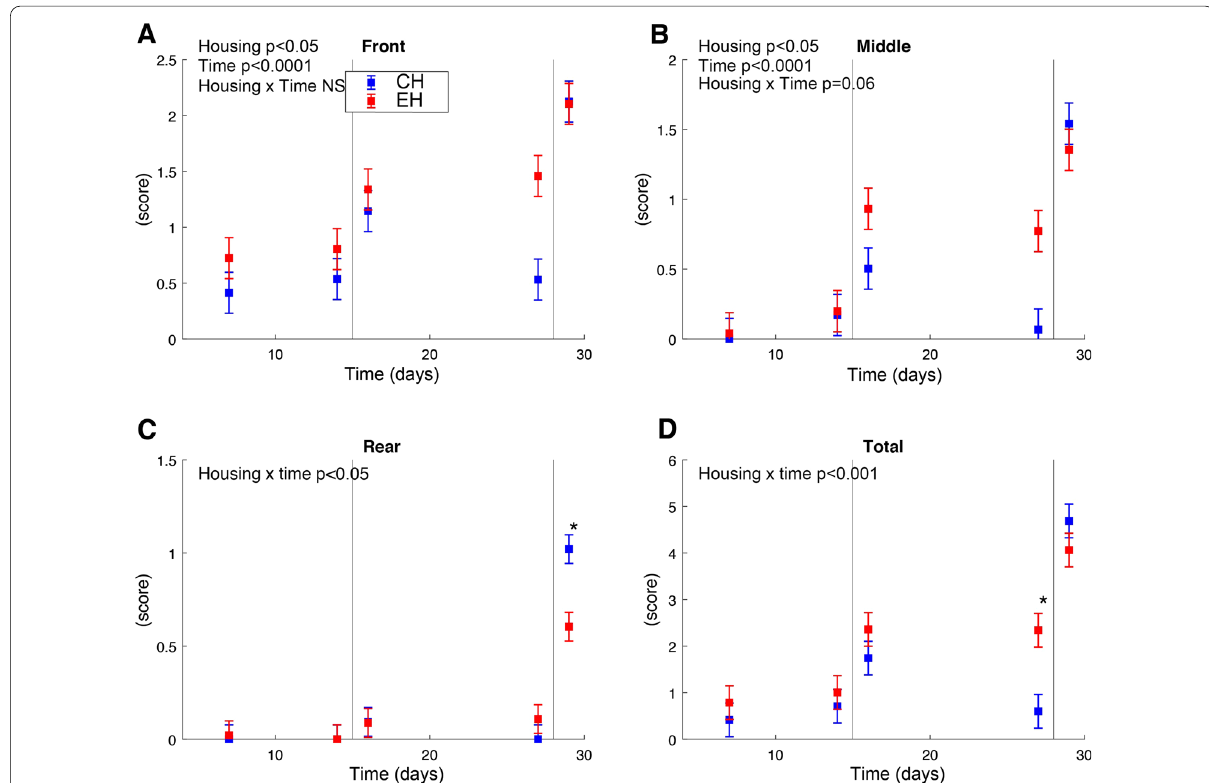
Fig. 2 Skin lesion scores (mean of a four‑point scale standard error). A – C Scores from the front, middle and rear of pigs, respectively. D Shows all ± scores. Blue and red colours represent conventional housing (CH) and enriched housing (EH), respectively. ‘*’ indicates a significant difference for CH versus EH pigs (post hoc comparison, p < 0.05). The vertical lines at day 15 and 28 indicate socialisation in the EH pigs and weaning for both